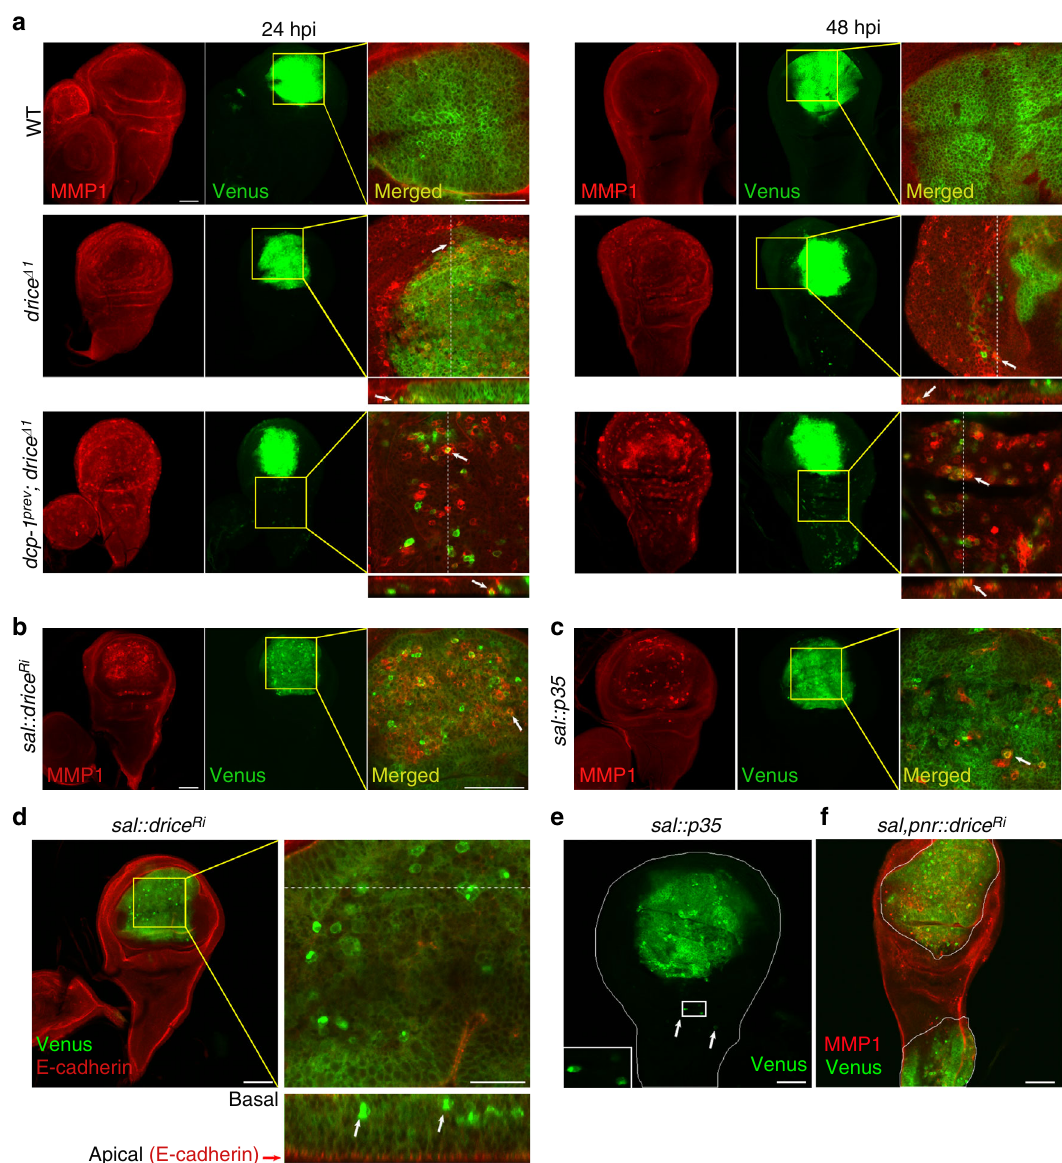
Fig. 5 Compromised caspase activity in the invaded tissue enhances cell invasion. Migrating cells are marked in green (intense Venus expression). a ICM levels directly correlate with MMP1 expression levels. Selected images of WDs from the indicated genotypes at 24 and 48 hpi (50 Gy) stained with anti- MMP1 antibody (red). The images on the right of each panel represent higher magni fi cations of the merged (red and green) channel areas indicated by the yellow squares. Dashed lines indicate the regions for which Z -axis projections (bottom) were generated. b , c Con fi ned knockdown of drice or overexpression of p35 in the pouch areas of irradiated (40 Gy or 50 Gy, respectively, 48 hpi) WDs induces MMP1 expression only in the pouch. Images were organized as in a . White arrows in a – c indicate migrating cells that are also MMP1-positive, as this feature appears to be transient. d Knockdown of drice in the pouch area induces migrating cells that are mainly con fi ned to this area of the irradiated (50 Gy, 48 hpi) WD. Scale bar, 50 µ m. The image on the right is a higher magni fi cation of the area indicated by the yellow square; scale bar, 20 µ m. White arrows indicate migrating cells displaying delamination pattern, loss of apical E-cadherin expression, and cell morphology, which are highly reminiscent of the migrating cells induced when effector caspase function is compromised in the entire larva (compare with Fig. 4b). A dashed line indicates the region for which a Z -axis projection (bottom) was generated. e Pouch area overexpression of p35 also induces area-con fi ned ICM in irradiated (40 Gy, 48 hpi) WD. The inset contains a higher magni fi cation image of the area marked by a rectangle. White arrows indicate relatively rare migrating cells which invaded the surrounding WT tissue. f Simultaneous knockdown of drice in the pouch and the notum induces area-con fi ned ICM and MMP1 expression in irradiated (40 Gy, 48 hpi) WD. Scale bars in a – c , e , f , 50 µ